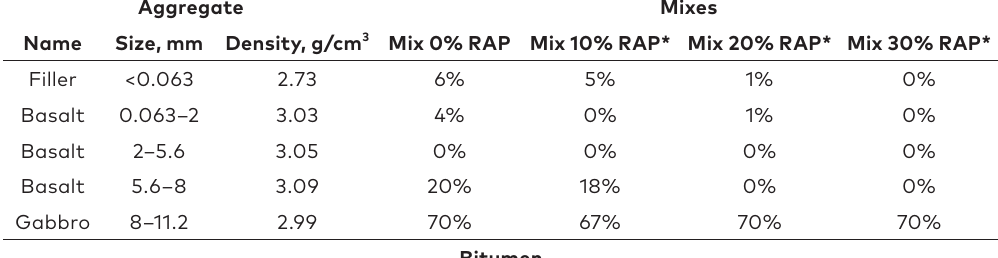
mixtures and bitumen